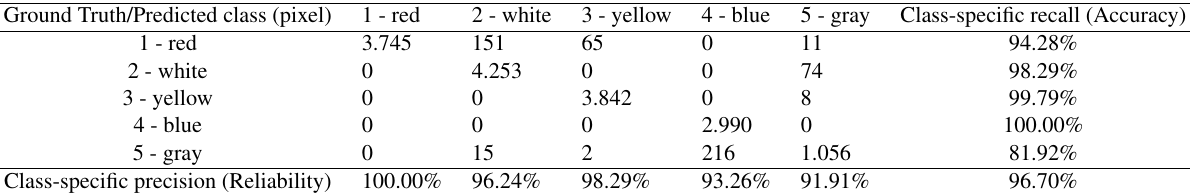
Table 4. Per pixel classification confusion matrix based on the orto rectified image of 2012 acquisition, including the depth